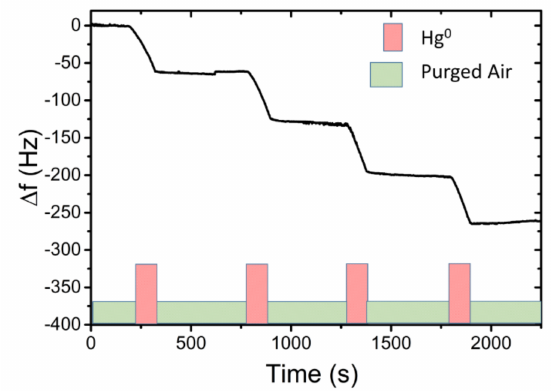
Figure 8. Cycles on-off of exposition at 6000 µ g/m 3 Hg 0 , lasting 2 min and then purged